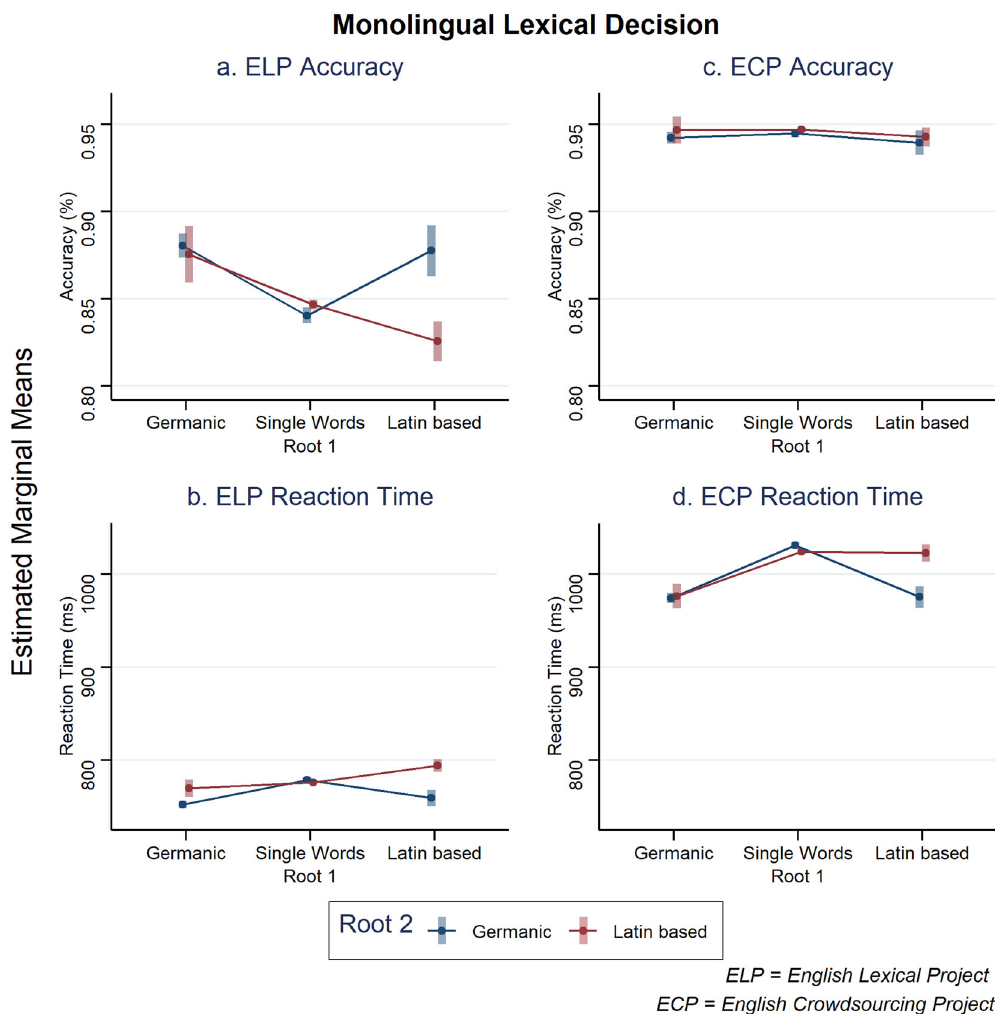
Fig. 4 English L2 learners are more accurate and faster for Latin-based items (red) relative to Germanic items (blue).